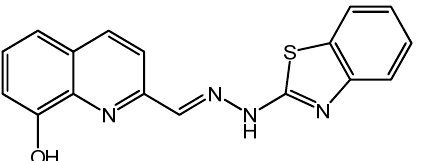
Figure 1. Molecular structure of H 2 L, a Schiff base derived from 8-hydroxyquinoline and